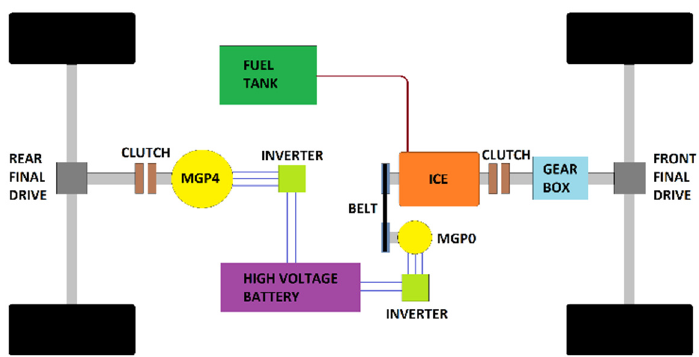
Figure 1. Schematic diagram of a parallel-through-the-road HEV powertrain. Table 1. Parameters of the parallel-through-the-road plug-in HEV powertrain. Component